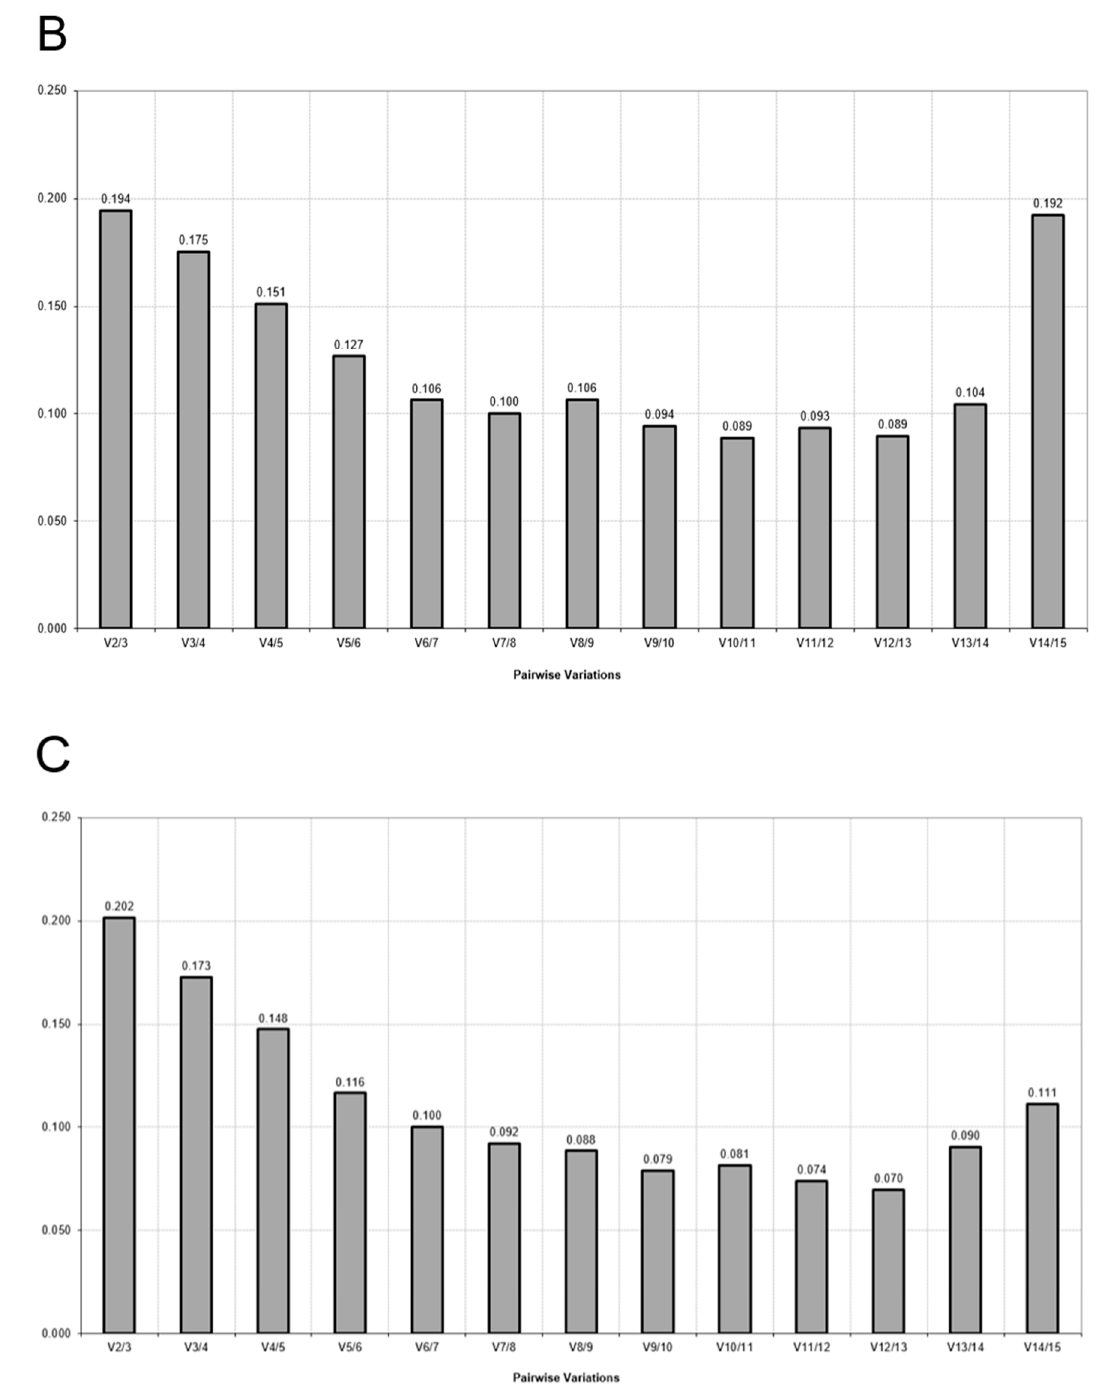
Figure 2. Determination of the optimal number of reference for normalization performed by pairwise variation analysis of candidate HKG under acid pH ( A ), physiological pH ( B ) and under both acid and physiological pH ( C ) culture conditions. A variation coefficient ( V ) below 0.15 indicates the optimal number of genes required for data normalization.